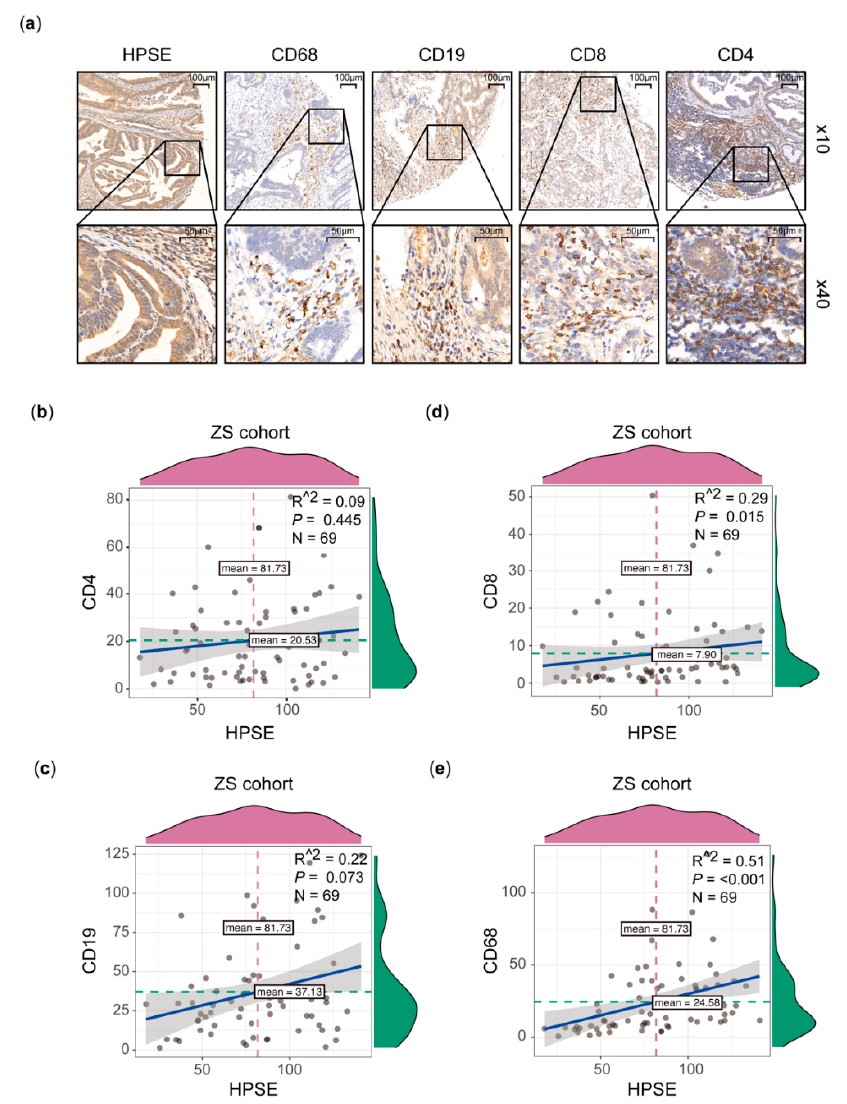
Figure 4. Correlation analyses of HPSE expression and the immune cells infiltration in ZS cohort. ( a ) Representative images of immunohistochemistry staining. ( b ) The correlation between HPSE expression and CD4+ T cell infiltration. ( c ) The correlation between HPSE expression and CD19+ B cell infiltration. ( d ) The correlation between HPSE expression and CD8+ T cell infiltration. ( e ) The correlation between HPSE expression and CD68+ macrophages